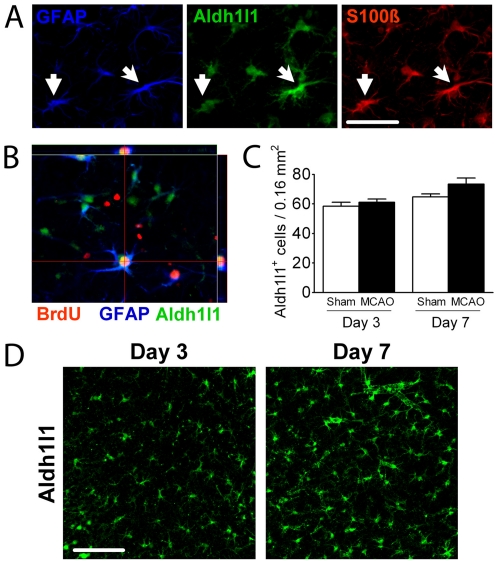
Few Aldh1l1+ astrocytes proliferate in the cortical penumbra.(A) Triple labelling reveals that most astrocytes in the cortical penumbra label for GFAP, Aldh1l1 and S100β. (B) Orthogonal view of a mature astrocyte co-expressing Aldh1l1, BrdU and GFAP in the cortical penumbra. (C) The number of Aldh1l1+ astrocytes assessed in layers II–III of the cortical penumbra does not change over the first week post-injury, or compared to sham animals. (D) Illustrative confocal micrographs show increased prominence of Aldh1l1 positive cells with cellular hypertrophy, but no change in overall number. Scale Bar, 50 µm.